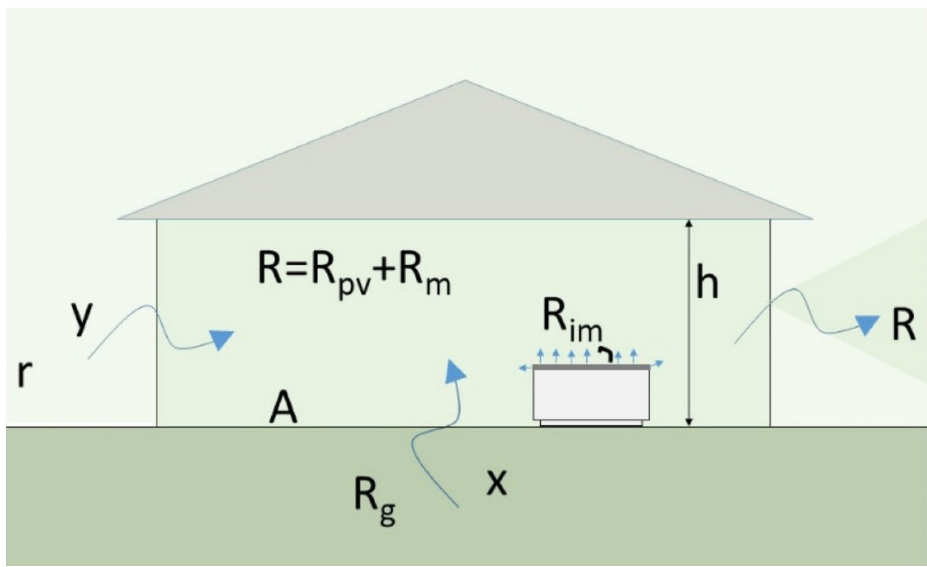
Figure 2. The equilibrium equation describes the equilibrium between the constant radon concentra- tion in the indoor air (R), and the radon supply from soil gas (R g ), exterior air (r) and indoor materials (R im ) for a constant air-pressure difference between the interior and exterior over